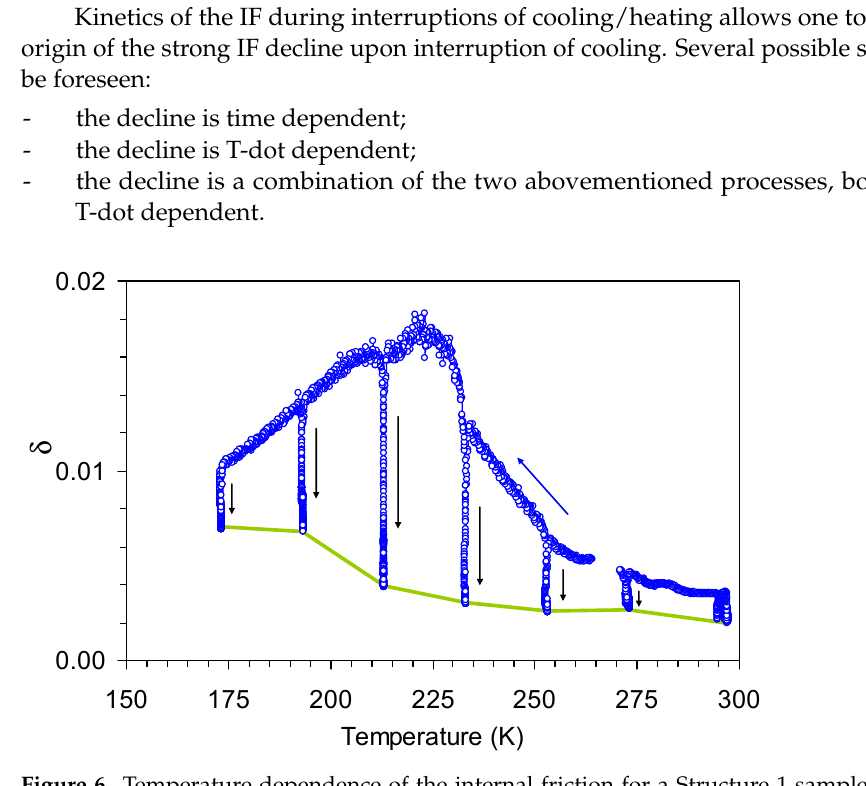
Figure 5. Example of the time dependence of temperature in one of the cooling–heating scans that was interrupted for 2400 s at 273, 253, 233, 213 and 193 K on cooling and at 193, 213 and 273 K on heating. Figure 6 exemplifies the results of one of the cooling scans interrupted at several